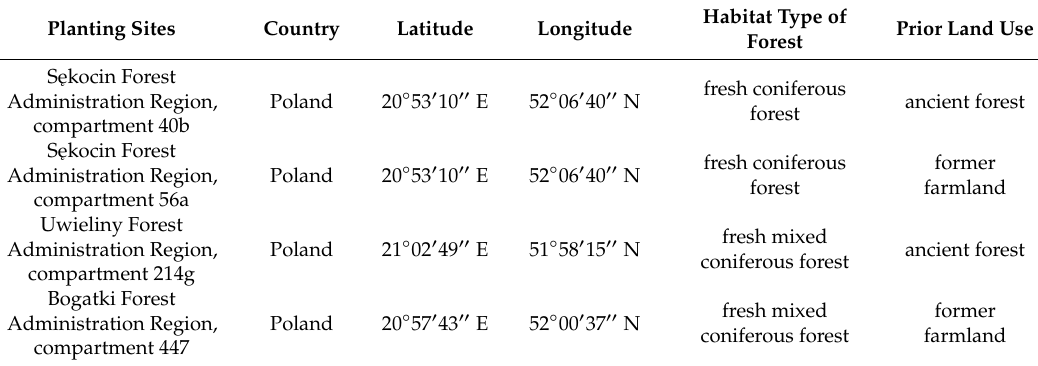
Table 1. The location and basic data of four experimental plots in the Chojn ó w Forest